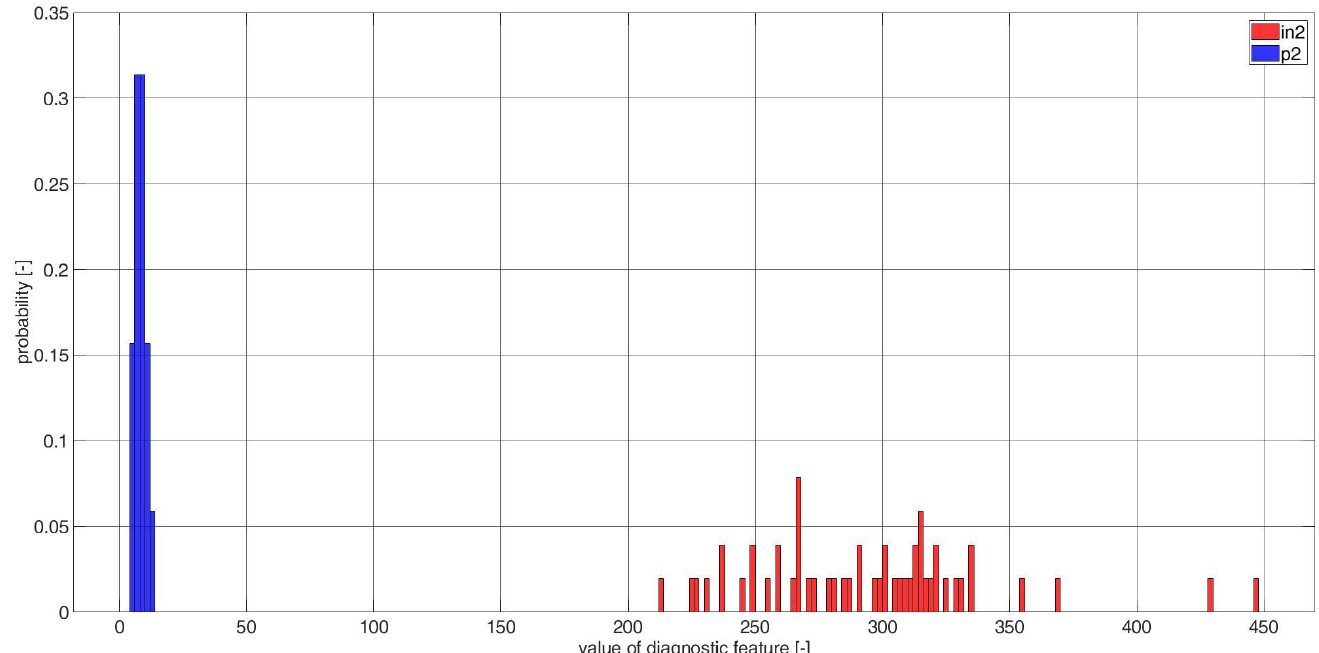
Figure A23. Histograms of diagnostic features based on the CCSM3 (correlation number is 24— Table A1) bearings in1 and p1. Table A1) bearings in1 and p1.